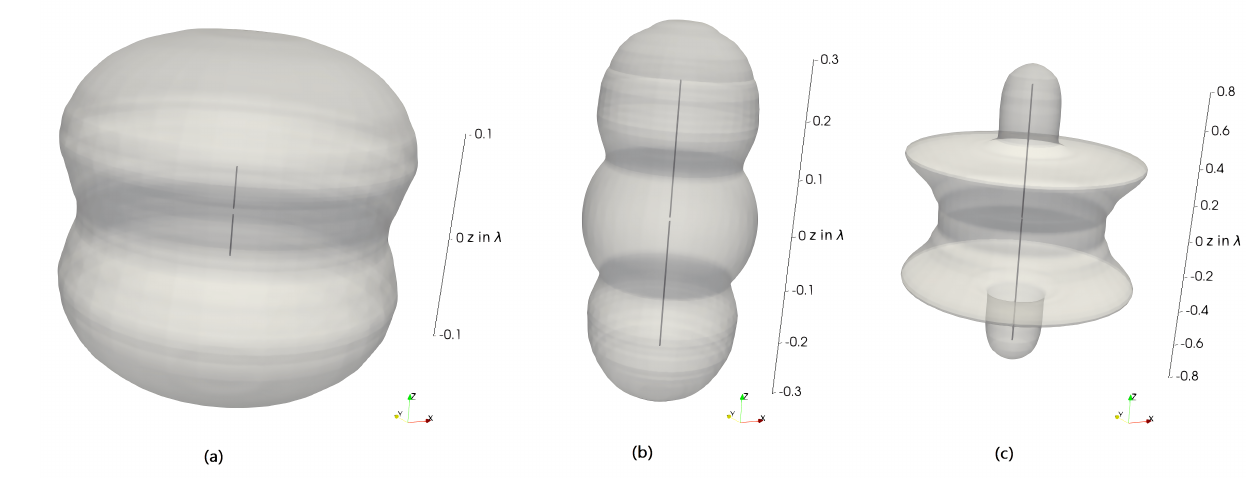
Figure 12. The reactive NF region, described by the angular-dependent radius r near ( θ , φ ) , when applying the error estimator 11 with err NR 2 ( r near ( θ , φ ) , θ , φ ) = 1 of a ( a ) 0.1 λ ( b ) 0.5 λ , and ( c ) 1.5 λ dipole. The corresponding dipole can be seen inside the